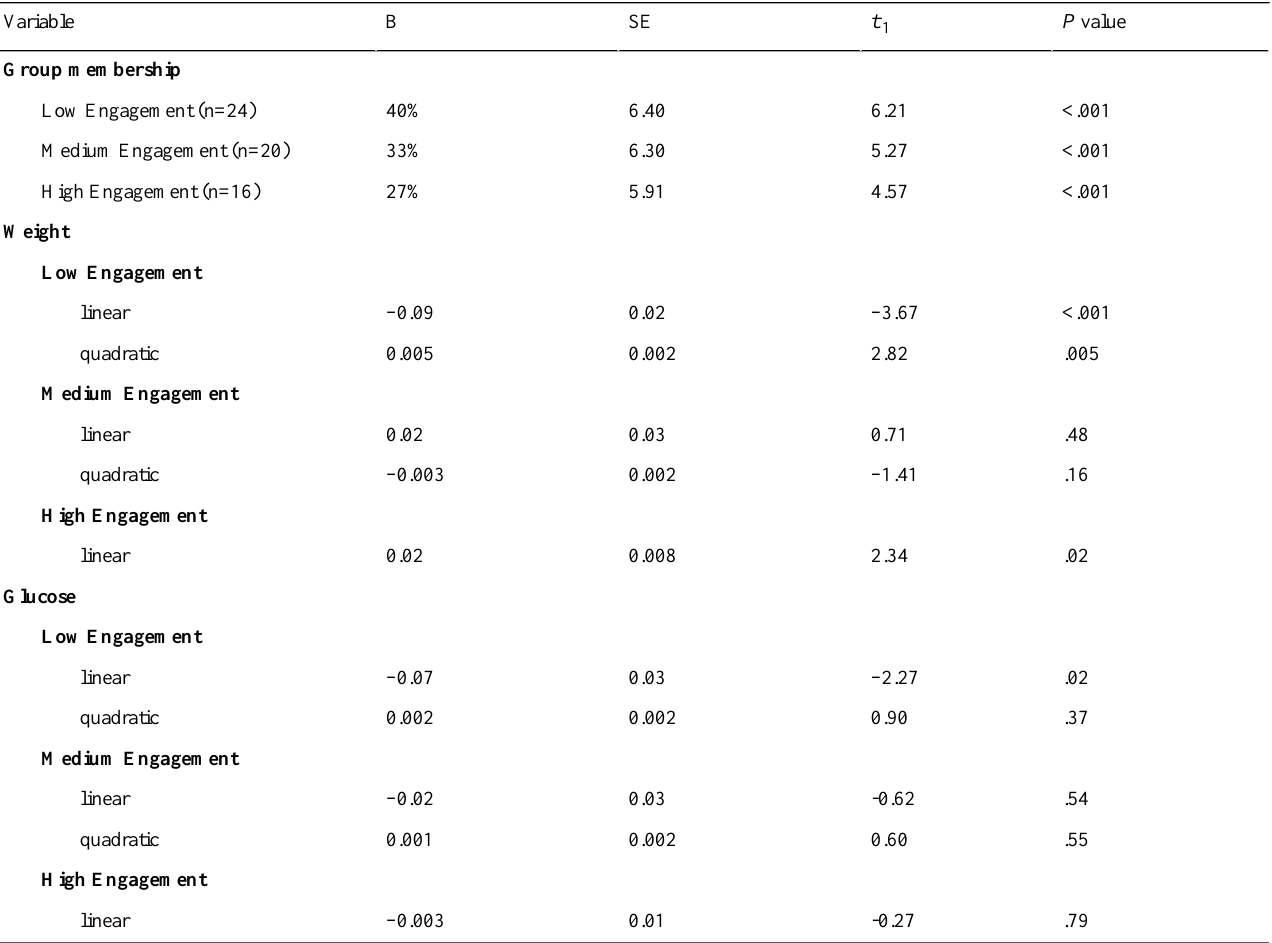
Table 3. Latent class growth analysis multitrajectory model results for engagement with a wireless weight scale and glucometer (N=60).